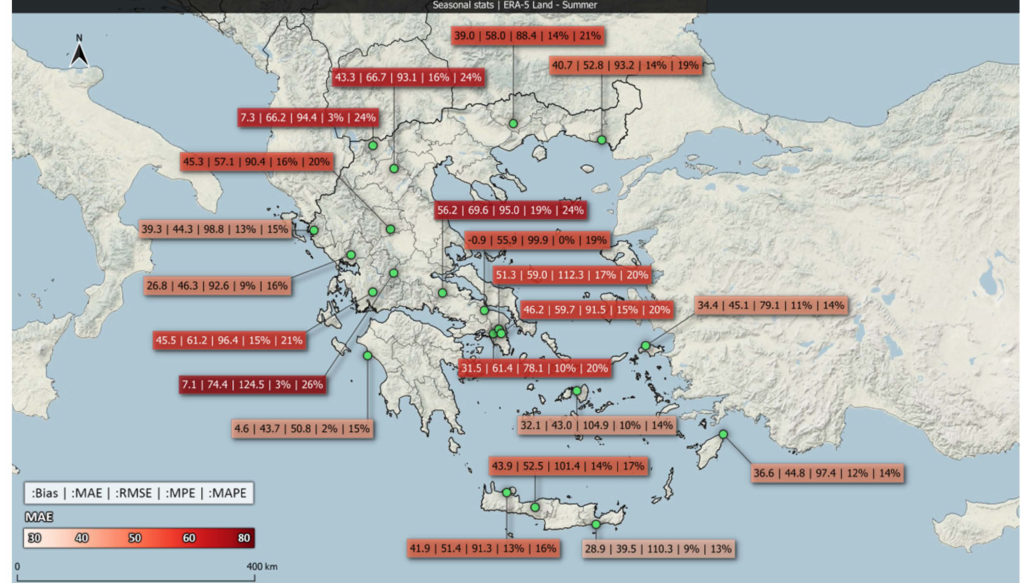
Figure 5. Bias (W/m 2 ), MAE (W/m 2 ), RMSE (W/m 2 ), and MPE and MAPE (both ranging from 0 to 1 for better visualization) between ERA5-Land and surface observations for summer (JJA) in the Greek